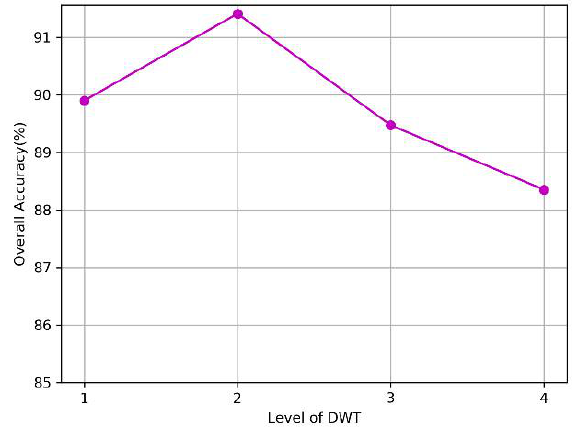
Figure 8. The impact of Multilevel-DWT.